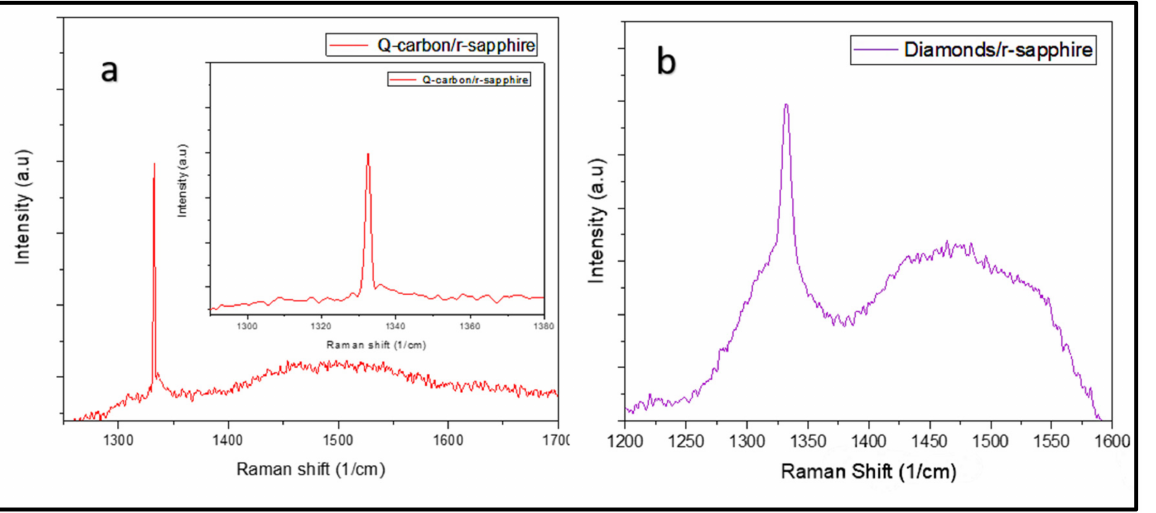
Figure 8. Raman spectra obtained from different regions in the CVD microdiamond film grown on ( a ) Q-carbon/nanodiamond seeds at 1332.5 cm − 1 and ( b ) nanodiamond seeds showing peak at 1333.3 cm − 1 on r-sapphire